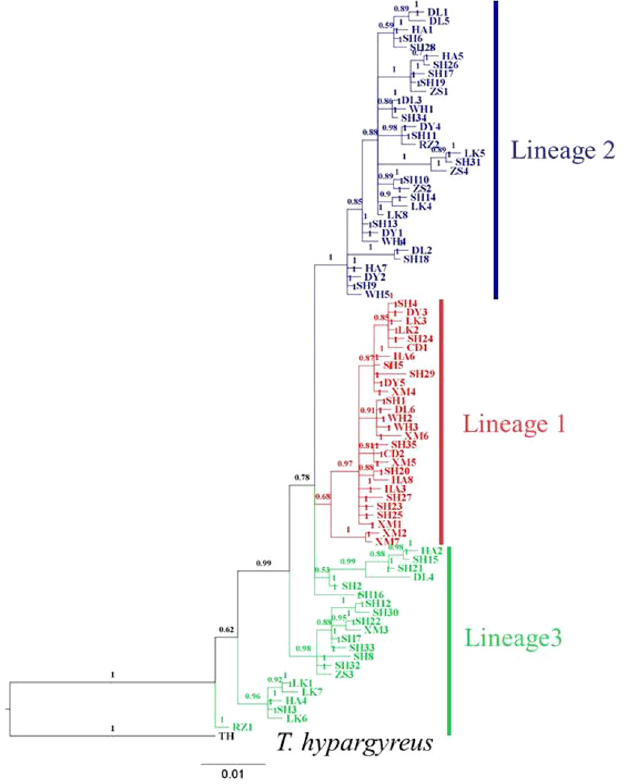
Fig. 4. Bayesian inference (BI) tree of haplotypes in T. modestus